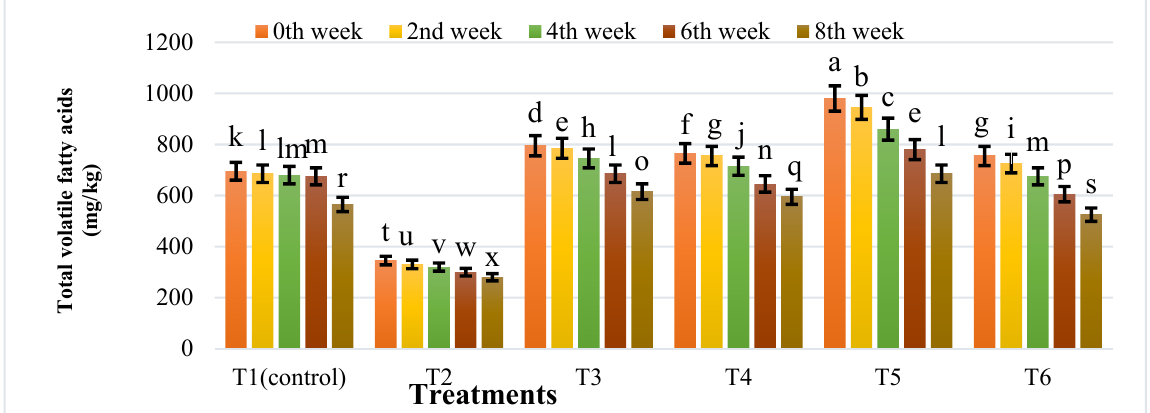
Figure 10. Effects of different treatments of IONPs on TVFA value during anaerobic digestion of cattle manure. Bars with different letters indicate significant differences ( p ≤ 0.05) between treatments.